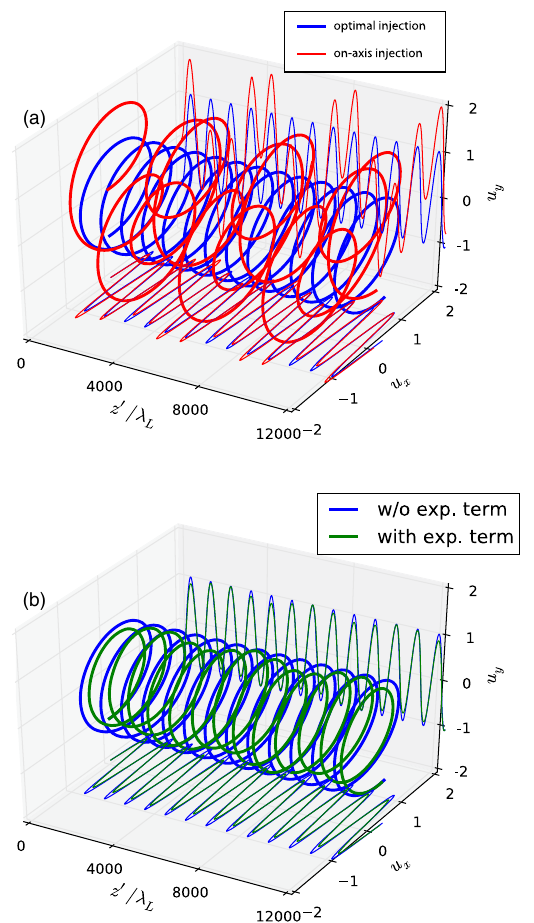
FIG. 2. Electron dimensionless transverse momenta compo- nents u x and u y as functions of the propagation distance z 0 = λ L . The blue curve corresponds to the case of injection of an electron with ð x e; 0 ; y e; 0 Þ ¼ ð − a u = ð γ 0 Ω Þ ; 0 Þ and ð u x; 0 ; u y; 0 Þ ¼ ð 0 ; − a u Þ into the circular undulator with a u ¼ 1 . (a) The red curve is the case of the electron injection with ð x e; 0 ; y e; 0 Þ ¼ ð 0 ; 0 Þ and ; u Þ ¼ ð 0 ; 0 Þ . (b) The green line corresponds to the case ð u x; 0 y; 0 of the electron injection conditions with ð x e; 0 ; y e; 0 Þ ¼ ð − a = ð γ Ω Þ ; 0 Þ and ð u ; u Þ ¼ ð 0 ; − a Þ , for the case when u 0 x; 0 y; 0 u the exponential term in Eq. (18) is